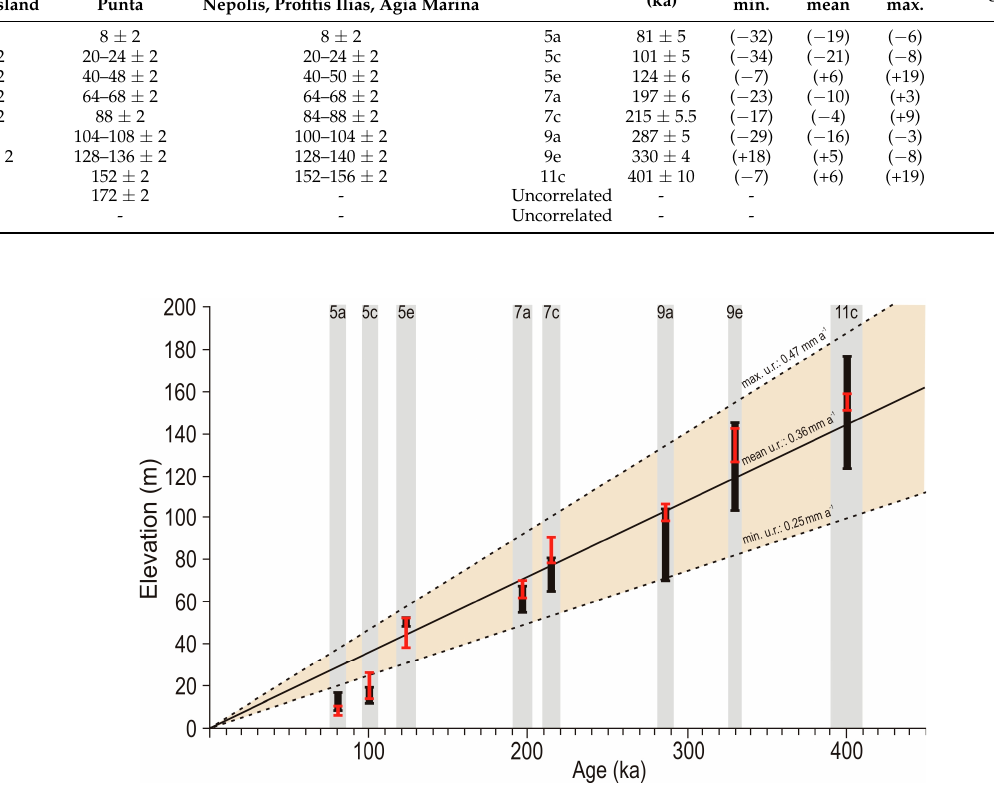
Figure 9. Comparative diagram of the predicted/expected marine terraces’ inner edge elevations’ ranges (marked by thick black lines) and the observed inner edge elevation ranges (marked by thin red lines) for the broader Neapolis area. The predicted elevation ranges of the inner edges (palaeo-shorelines) for each MIS were calculated under the assumption that the long-term uplift rate (0.36 ± 0.11 mm a − 1 ) was constant for the last 401 ± 10 ka and taking into account the age extend of each MIS highstand (according to Lisiecki and Raymo [88]—marked here as gray vertical bands), as well as the maximum and minimum position of eustatic sea-level for each MIS highstand (according to sea-level curve by Waelbroeck et al. [25]).